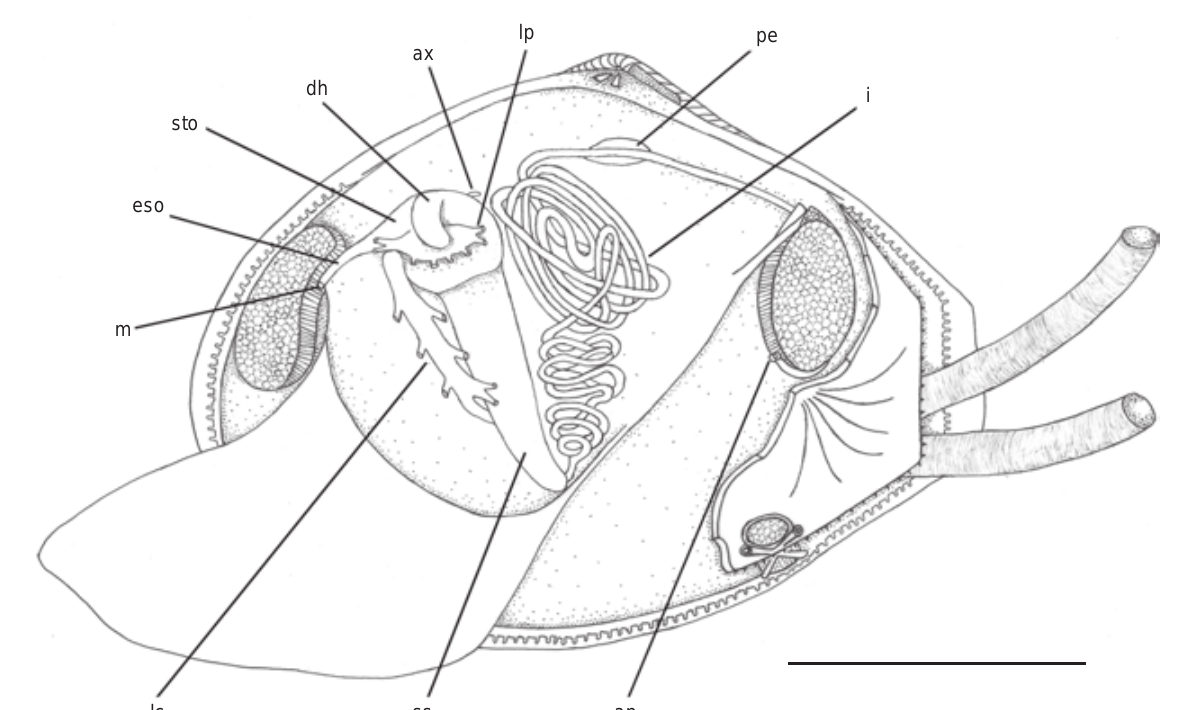
Figure 12. Macoma biota : left side view of a dissected specimen showing the alimentary canal. (ap) Anal papillae, (ax) appendix, (dh) dorsal hood, (eso) esophagus, (i) intestine, (lc) left caecum, (lp) lef pouch, (m) mouth, (pe) pericardium, (ss) style-sac, (sto) stomach. Scale bar: 1.5